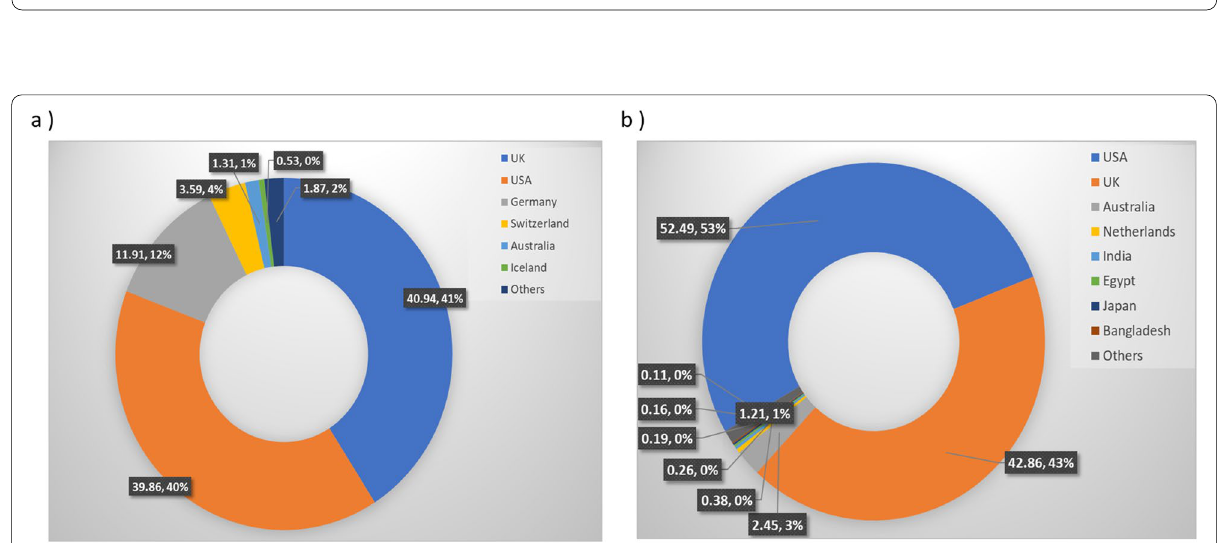
Fig. 1 Representation of the haplotype variants was observed in the severe acute respiratory syndrome coronavirus 2 (SARS-CoV-2) genome. a – d Represent the genomic location of each haplogroup identified in the nucleocapsid region which is a target of RT-PCR-based detection of severe acute respiratory syndrome coronavirus 2 (binding sites of primers recommended by the World Health Organization, the Centers for Disease Control and Prevention in USA and China, and Germany including Japan’s Center of Infectious Disease testing protocol. e – f haplotype variants were observed at nucleocapsid other than the RT-PCR target region